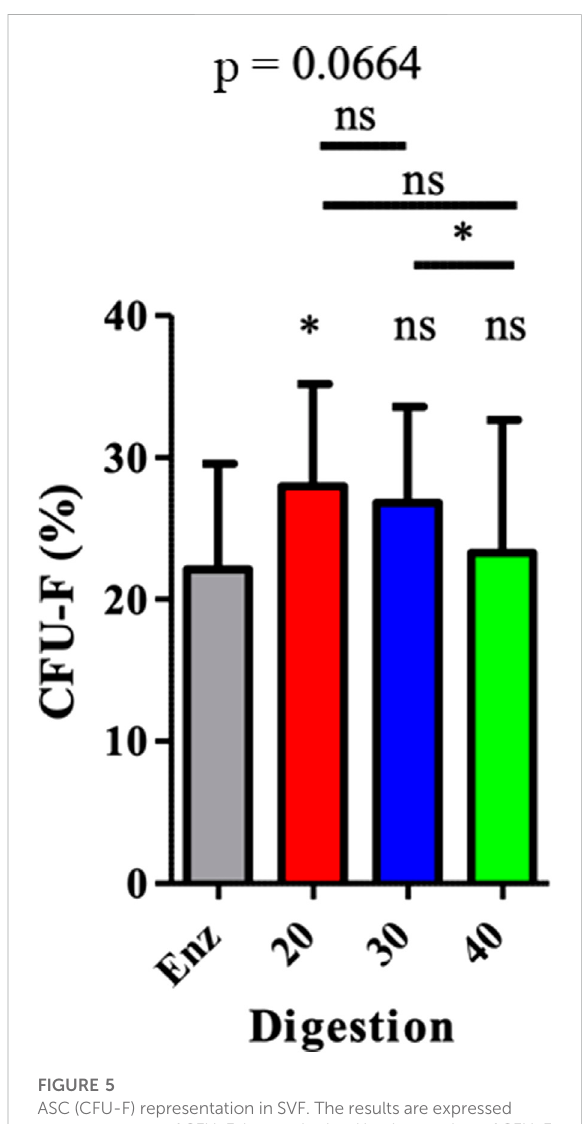
FIGURE 5 ASC (CFU-F) representation in SVF. The results are expressed asapercentageofCFU-F.ItwasobtainedbythenumberofCFU-F counted in relation to the number of cells sown. * p < 0.05, ** p < 0.001,and*** p < 0.0001;ns=notsigni fi cant.ASCs:adipose- derived mesenchymal stem cells; CFU-F: colony-forming unit – fi broblast; SVF: stromal vascular